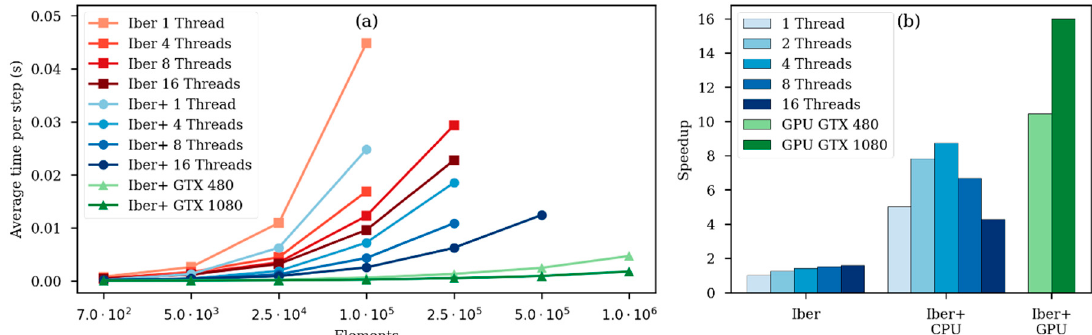
Figure 5. Average processing time per time step versus the number of elements of the simulated mesh using different configurations ( a ); Speedups obtained comparing Iber running in one thread with different configurations in Test 1 using a mesh of 700 elements ( b ).